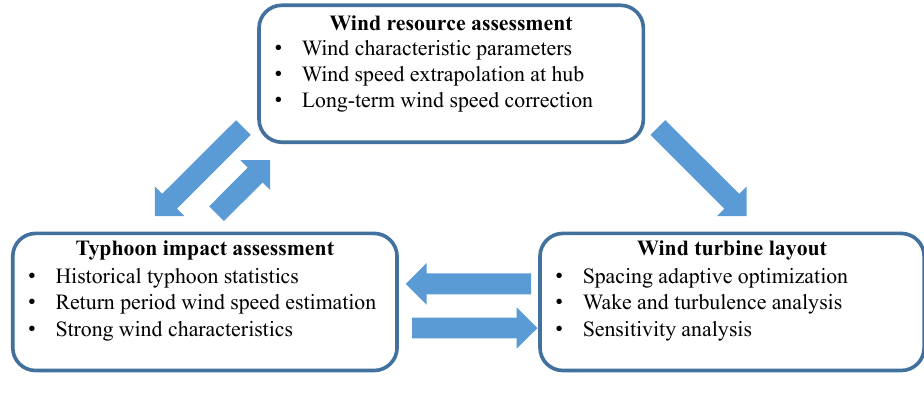
Figure 4. OWP resource